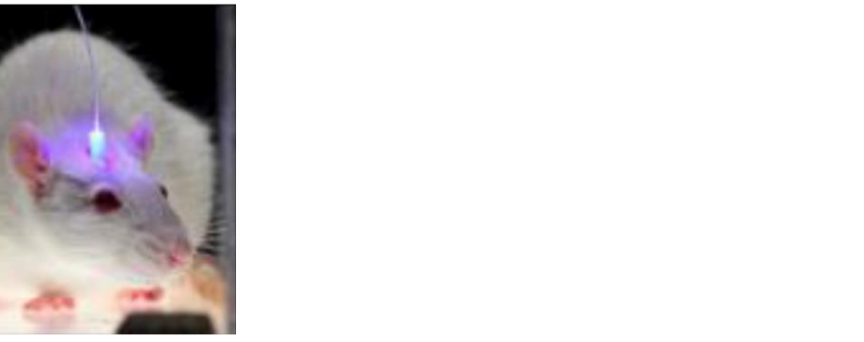
Figure 9. A fiber implanted into a freely behaving mouse. (Reprinted with permission from ref. [55]). Optogenetic technology combines optical and genetic technologies to control the excited or inhibited state of neurons. Transgene technology allows photosensitive proteins, such as ChR2 (which excites neurons) and NpHR (which inhibits neurons), to be expressed specifically on the membrane of neurons. Photosensitive proteins respond to different wavelengths [182]. The neurons will be controlled by light after transfection. However, due to the tissue’s low light penetration, light conduction must be accomplished using an implantable optical fiber. As a result, optogenetic technology relies heavily on optical fiber and photosensitive proteins. Optical fibers used for optical import are typically silicon- based in traditional optogenetic applications. Despite having low light loss, high stability, and low cost, Young’s modulus of the fibers is far from that of biological tissues. This poor compatibility can easily result in tissue damage, inflammation, and immune rejection [183], which is not ideal for long-term implant